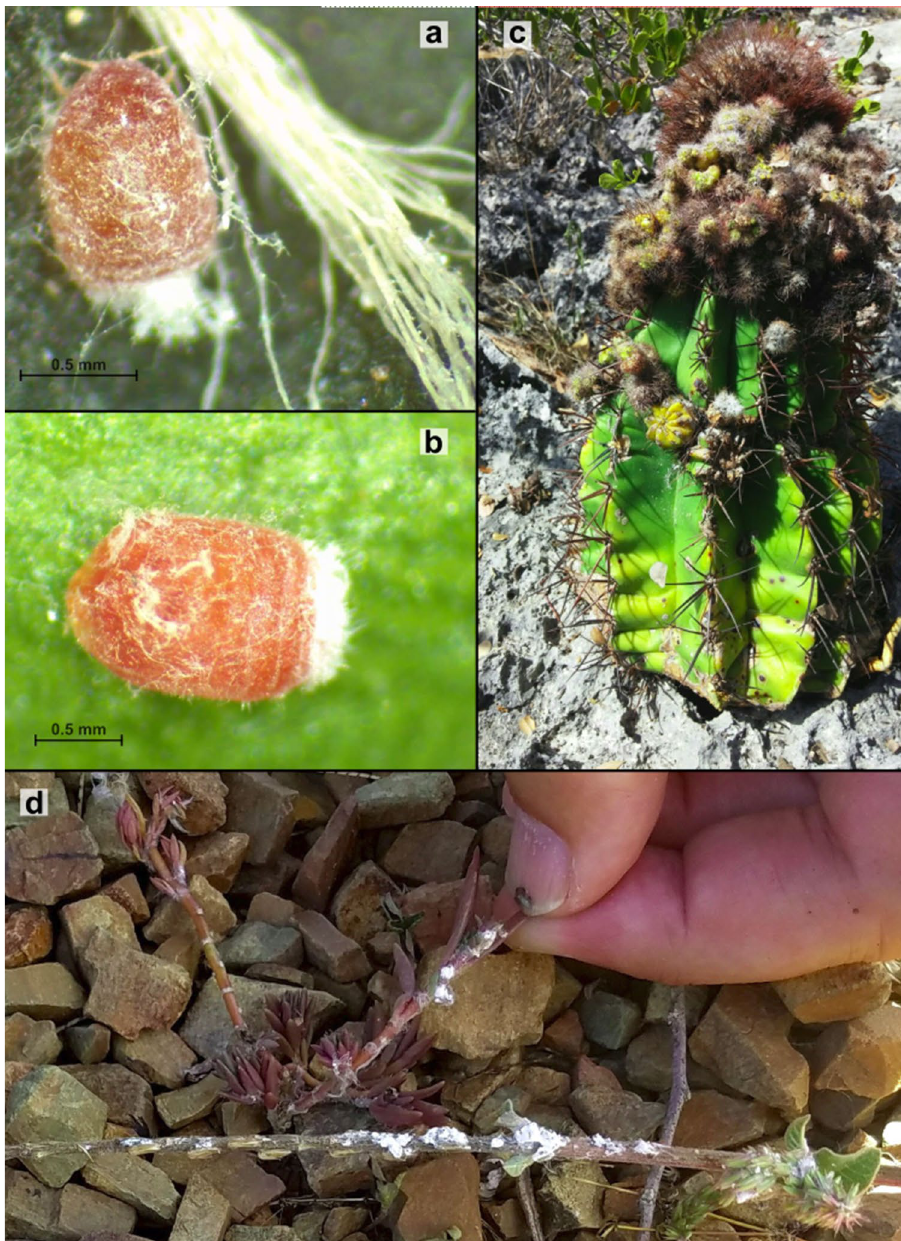
Figure 1. Adult females and host plant damage of both Hypogeococcus species invading Puerto Rico. Images showing adult females of Hyp-C ( a ) and Hyp-AP ( b ) as well as the typical damage of Hyp-C mealybugs on Cactaceae ( c ), and Hyp-AP on Amaranthaceae/Portulacaceae ( d ). Panel c shows advanced infestation by mealybugs causing deformation with shape of galls in a globular infested cactus. Plant held in the fingers of a researcher ( d ) shows the typical damage caused by Hyp-AP on Portulacaceae host plants, while the other plant on the lower panel d shows the damage on Amaranthaceae host